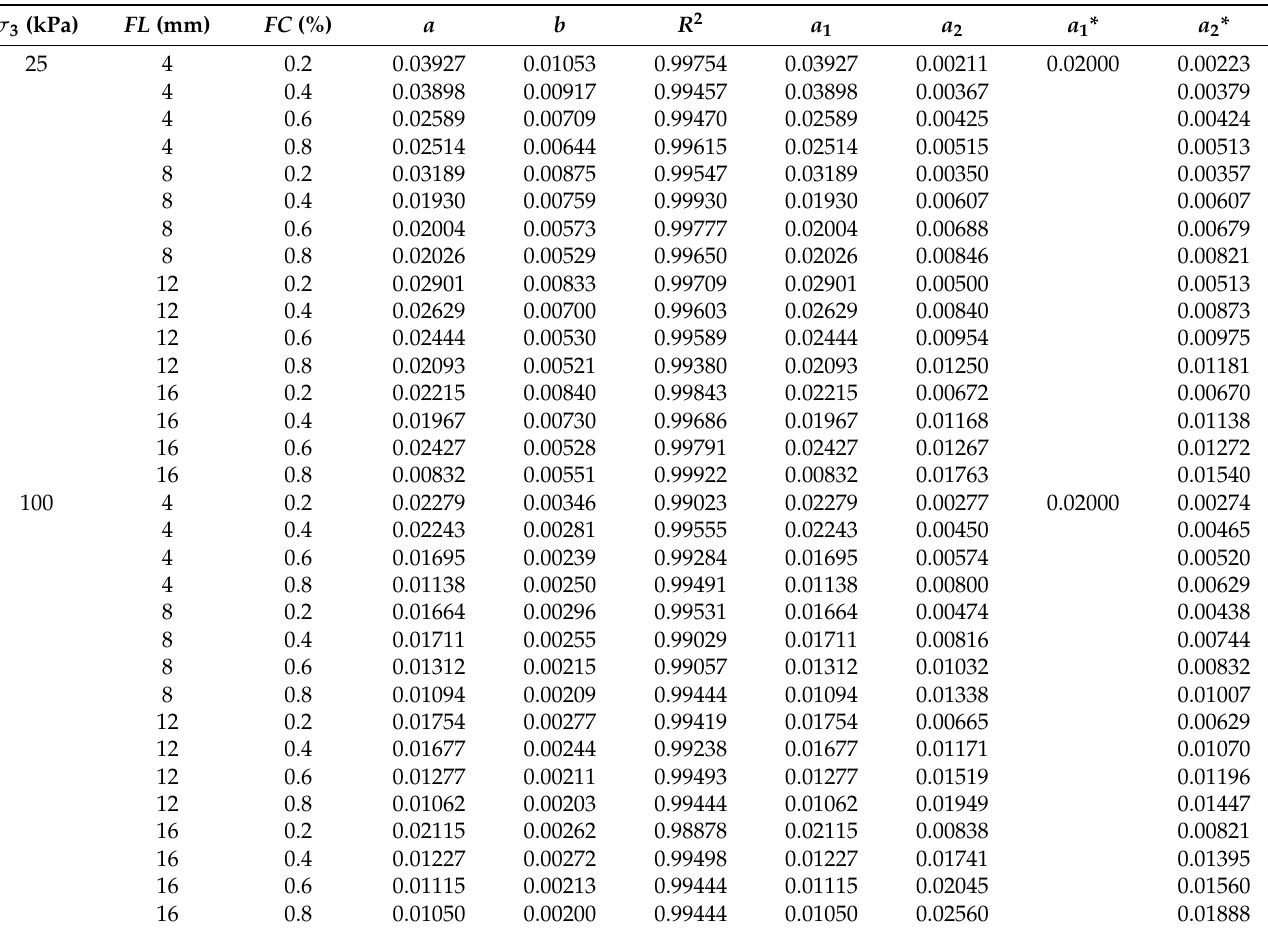
Table 5. Model parameters under 25 and 100 kPa cell